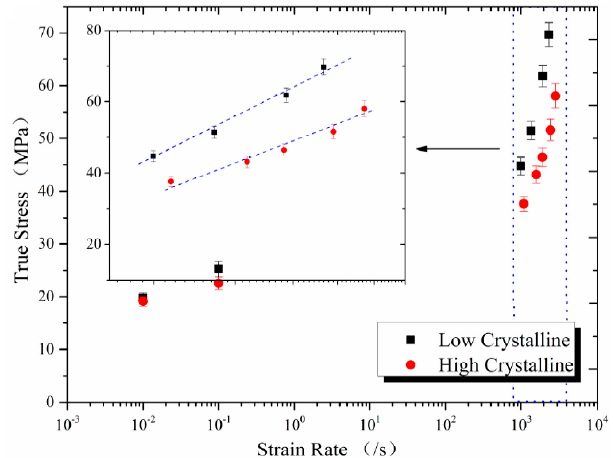
Figure 7. Comparison of true stress as a function of log (strain rate) between low crystalline and high crystalline Al-PTFE.